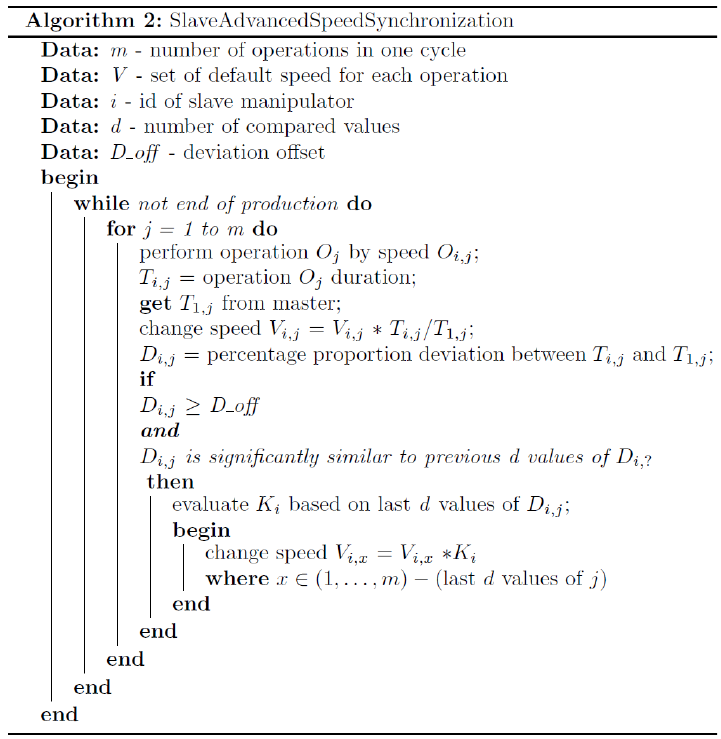
Figure 3. Advanced algorithm for synchronization of robotic cell operations.